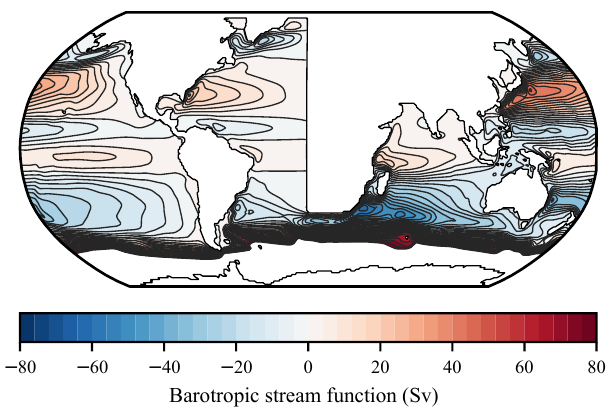
Figure 4. Long-term average barotropic stream function (BSF) of a 1 ◦ × 1 ◦ horizontal resolution setup as described in Sect. 4.1. 1Sv = 10 6 m 3 s − 1 . BSF values exceeding 80Sv are omitted. Contours are drawn in steps of